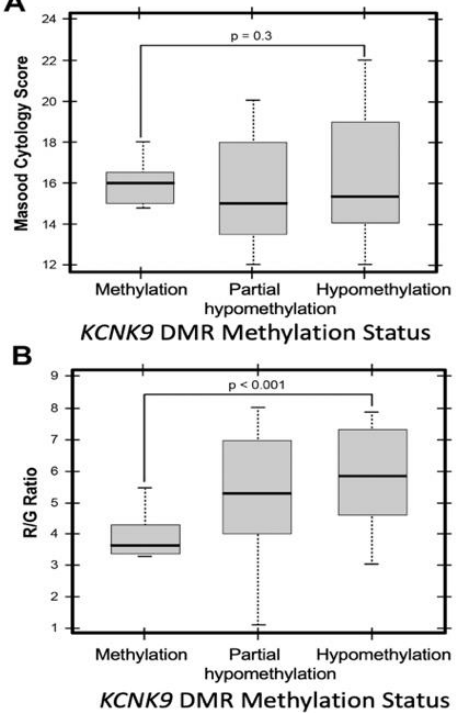
Figure 7. KCNK9 -US1 DMR methylation in breast epithelial cells aspirated from women at high risk for developing breast cancer. ( A ) Box plot of Masood Cytology Index Score versus KCNK9 -US1 DMR methylation status. ( B ) Box plot of R/G ratio versus KCNK9 -US1 DMR methylation status: methylation, partial hypomethylation, hypomethylation.